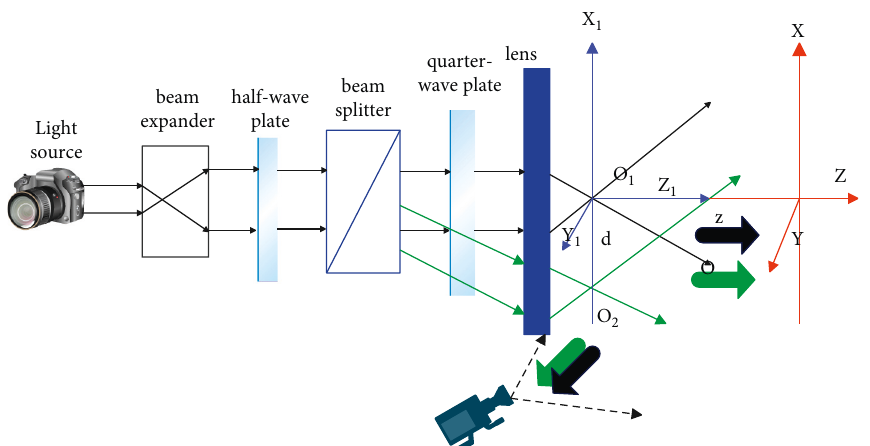
Figure 7: Construction of stray light intensity optical path based on polarization